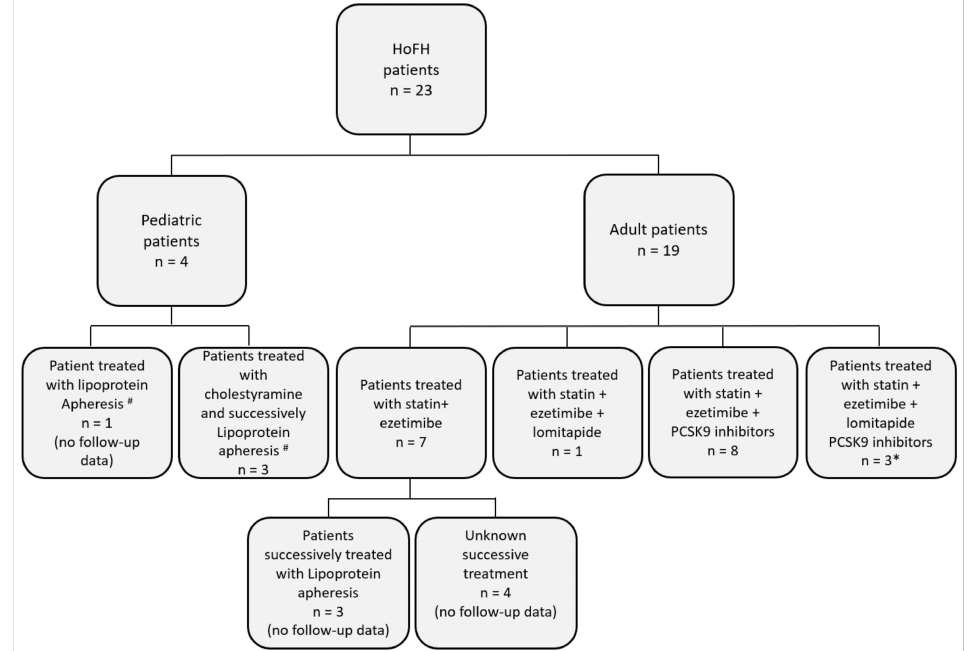
Figure 1. Diagram reporting treatment of Homozygous Familial Hypercholesterolemia patients. The di ff erent therapies used in homozygous familial hypercholesterolemia (HoFH) patients are reported. # Lipid profile after lipoprotein apheresis was unavailable; * Patients treated with lomitapide were five, but two suspended the therapy due to